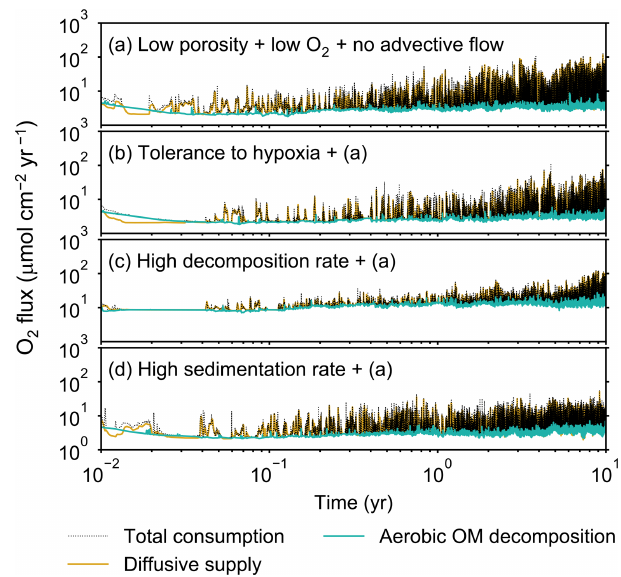
Figure 13. Time evolution of oxygen fluxes obtained from 10-year simulations with eLABS. See Sect. 3.3 and caption of Fig. 12 for the details of simulations (a–d) . Black dotted curves represent the to- tal oxygen consumption fluxes, orange curves the fluxes of oxygen supply via molecular plus eddy diffusion, and turquoise curves the oxygen consumption fluxes through aerobic degradation of organic